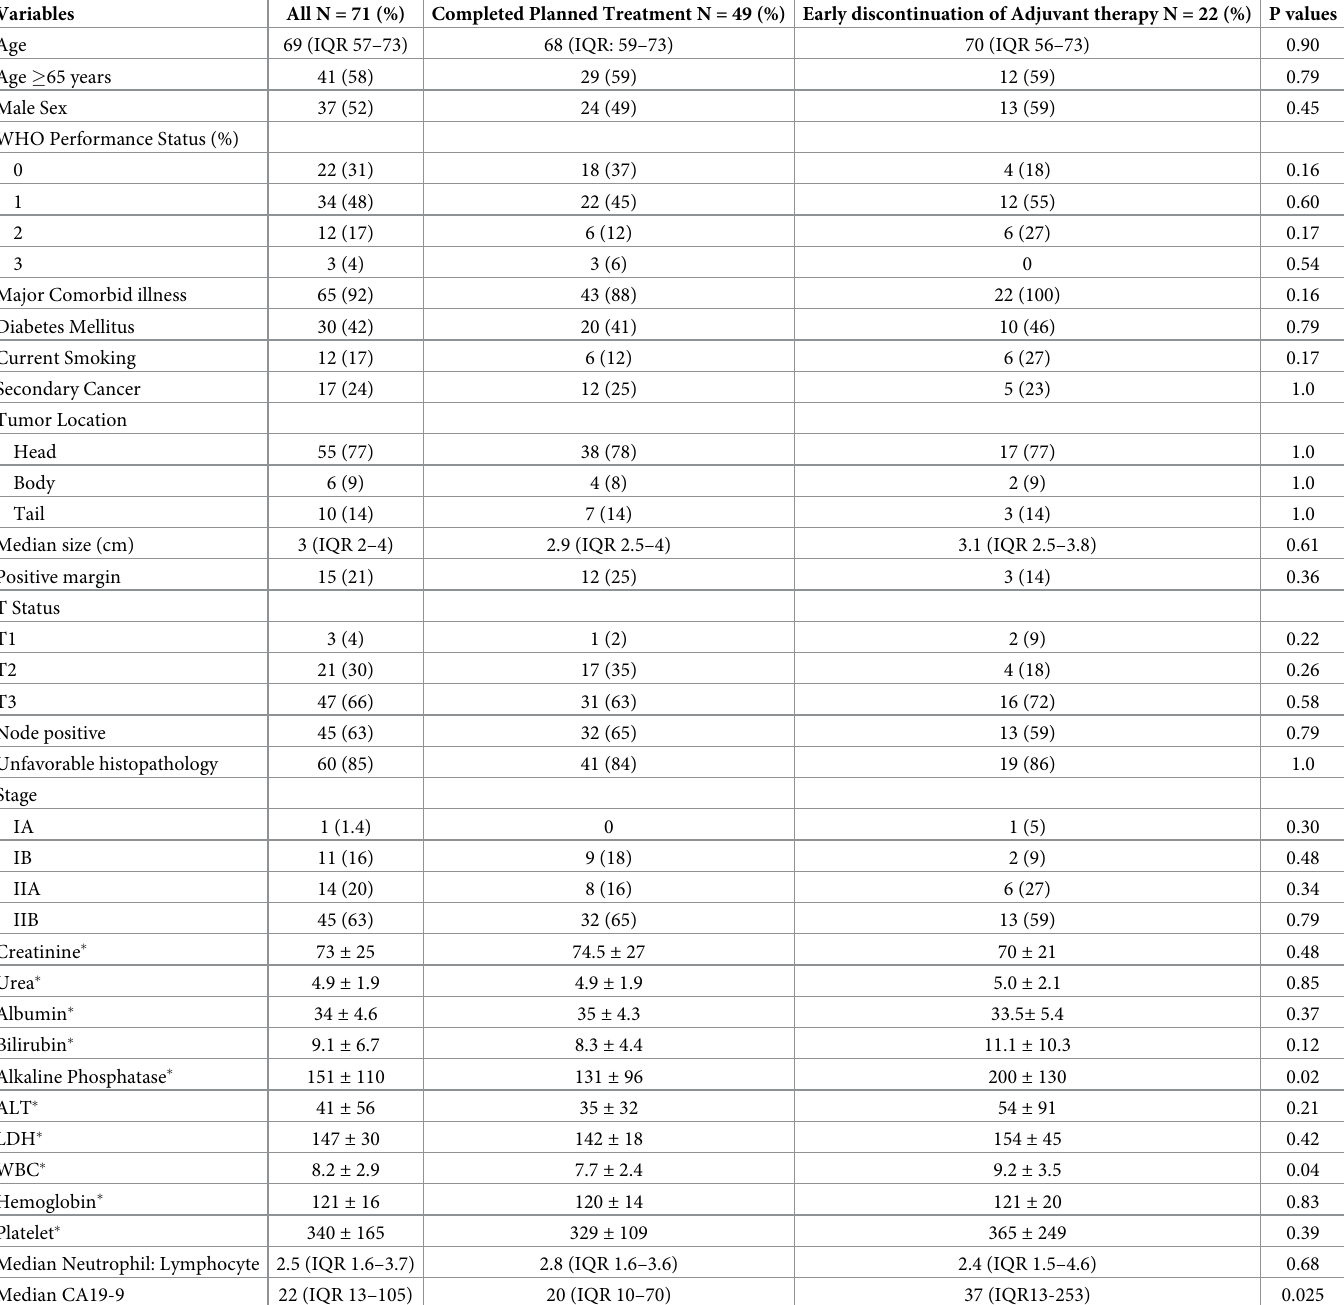
Table 1. Patients baseline characteristics prior to the commencement of adjuvant therapy.